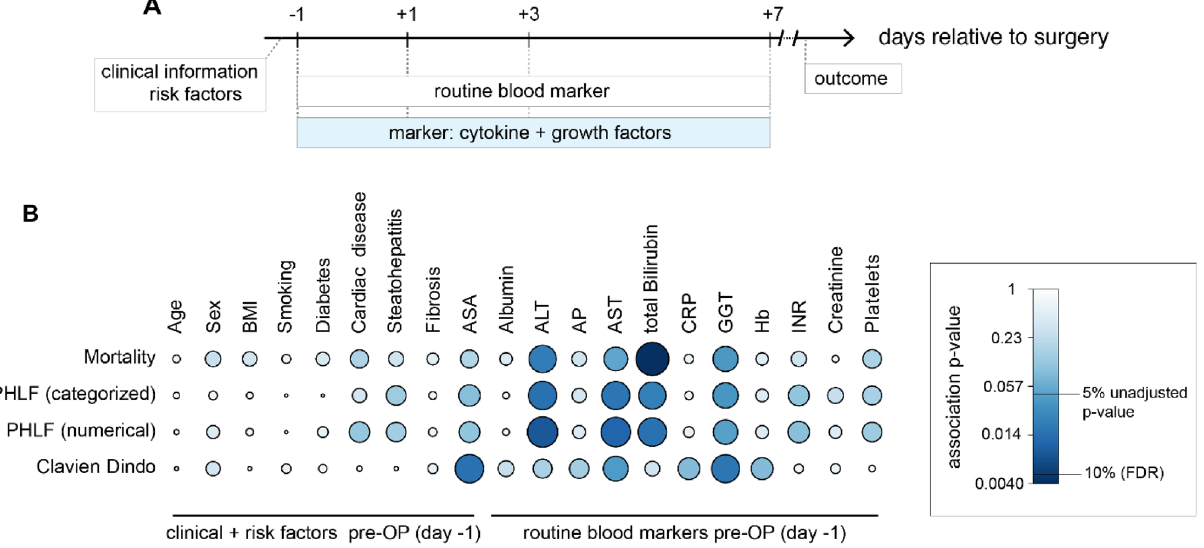
Figure 1. Study cohort overview of routine data and additional plasma marker. ( A ) Schematic overview of available data. ( B ) Pairwise-associations tests of routinely available preoperative data with four outcome parameters. Colors and size of the circle indicate the strength of association. The first nine columns correspond to general clinical information and known risk factors. The last 11 columns represent routine blood markers measured one day before surgery. The risk of mortality was significantly associated with the level of preoperative total bilirubin after adjusting for multiple testing (Kruskal–Wallis test unadjusted p value of 0.0033, FDR adj. p =